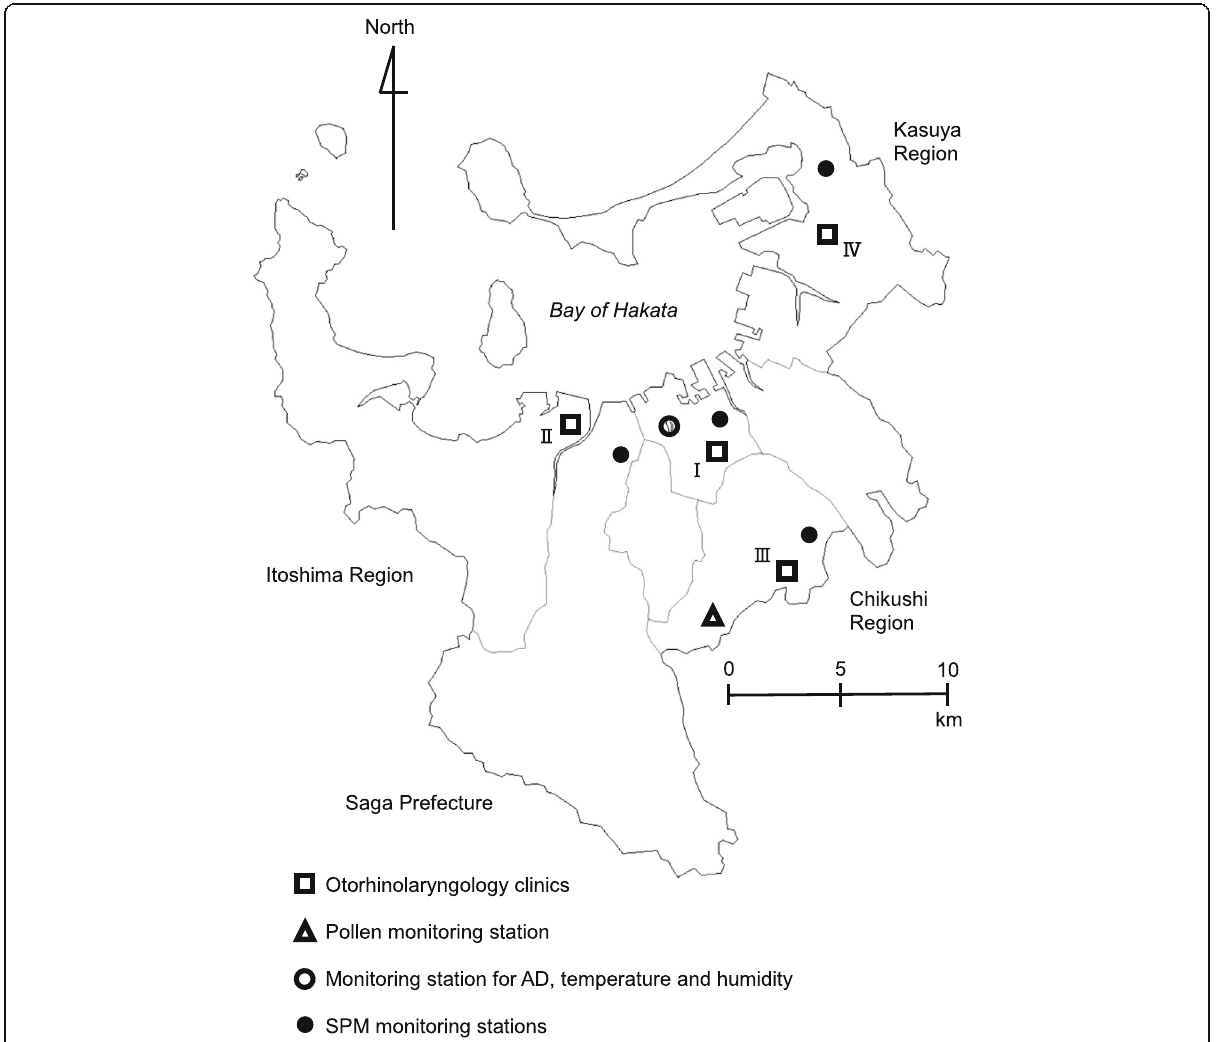
Fig. 2 Fukuoka City and the location of the otorhinolaryngology clinics and monitoring stations for air pollen, AD, SPM and weather